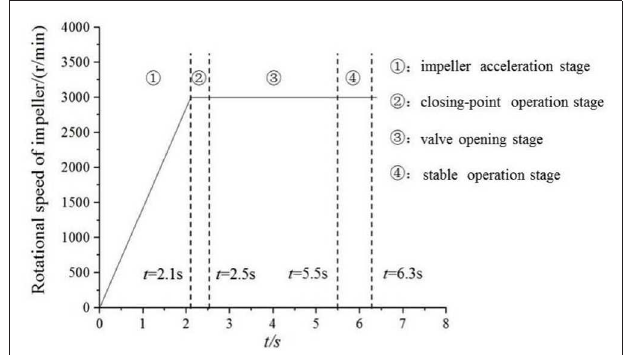
FIGURE 1 | Different stages of the start-up process.